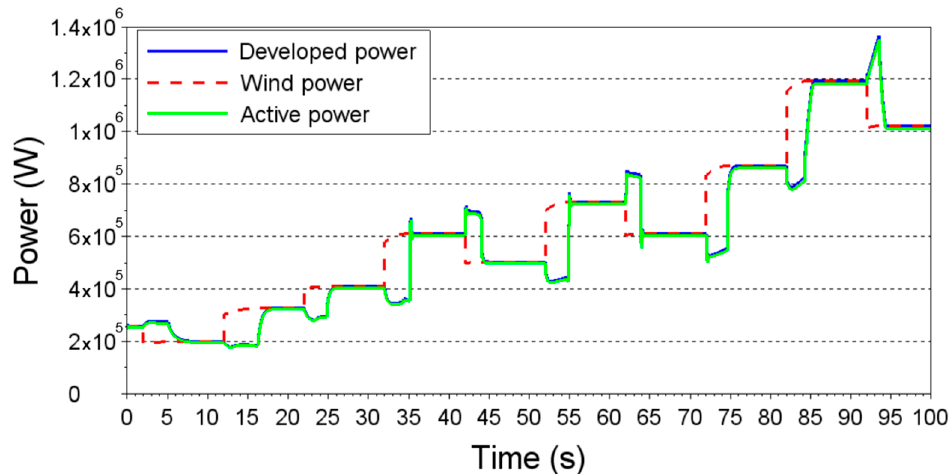
Figure 9. Developed, active and wind powers.